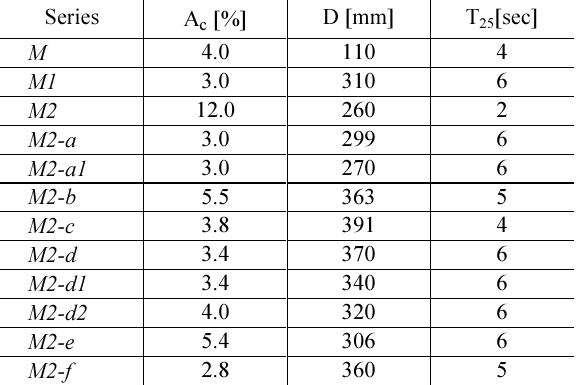
Table 3. Research results of fresh self-compacting mortar mixes